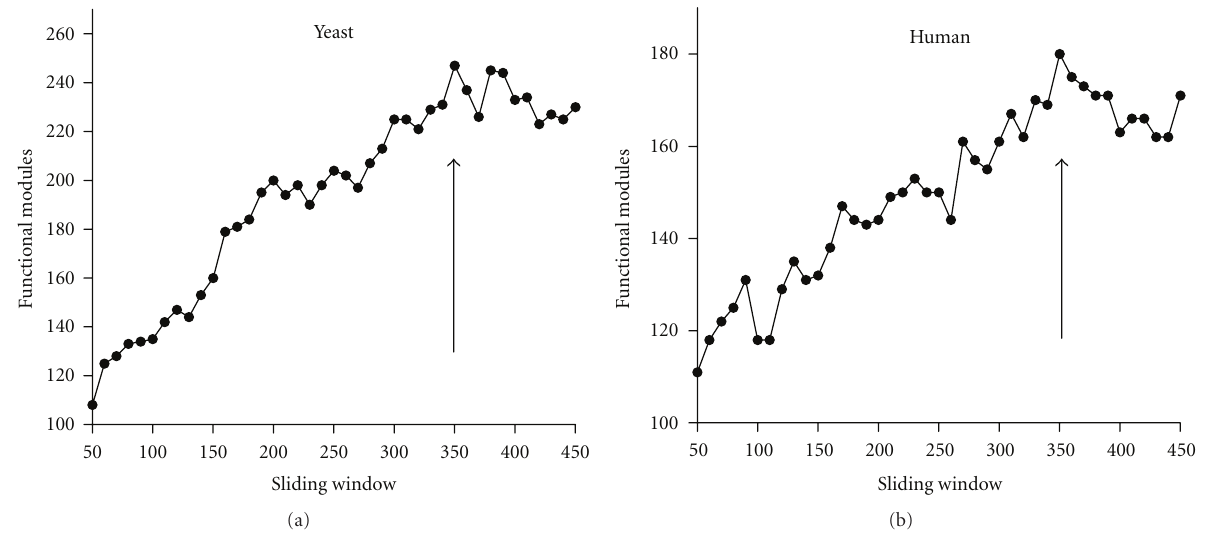
Figure 3: Performance of MOfinder in terms of various sliding window sizes for yeast and human network. The y -axis represents the number of functional modules. The threshold of 350 gives the best performance which can detect the maximum functional modules. (a) Yeast PPI network. (b) Human PPI network.